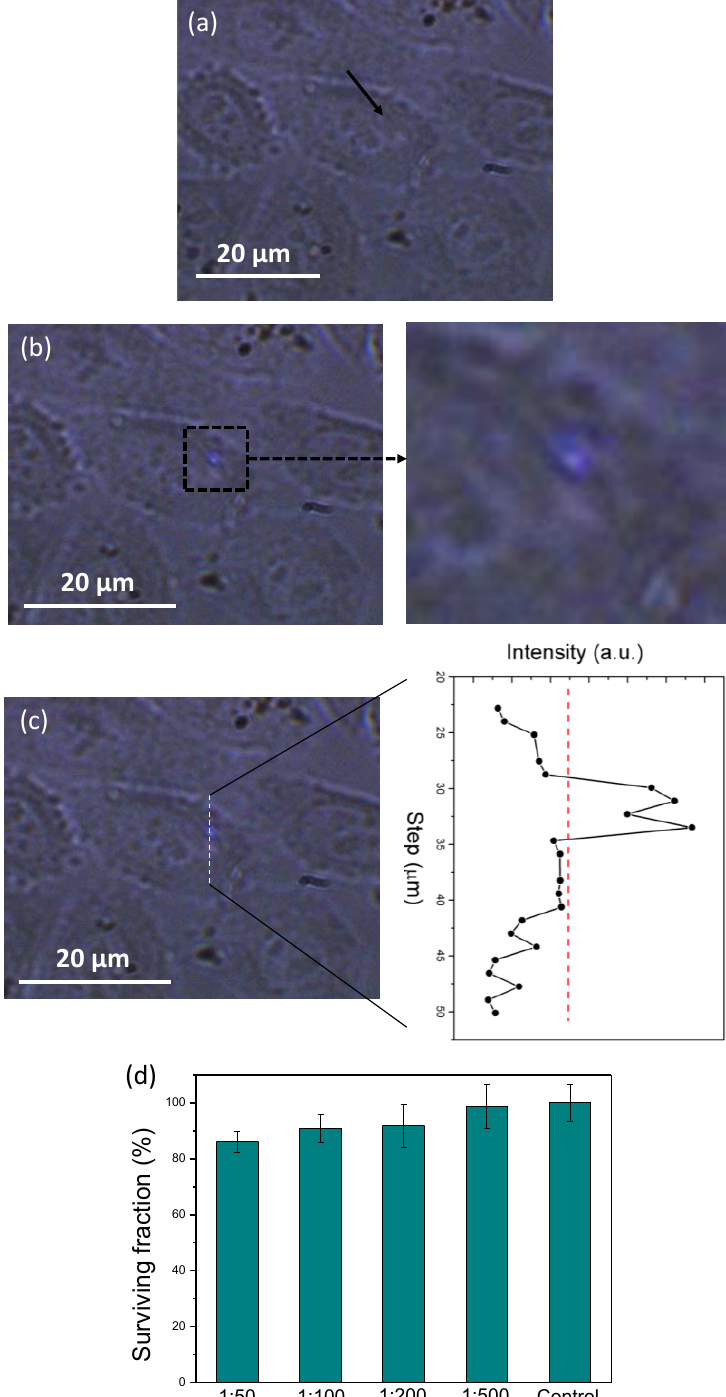
Figure 5. Microscope optical transmission images of the HeLa cells incubated with Tm,Yb:GdVO 4 @SiO 2 core-shell nanoparticles when the excitation laser is ( a ) off, and ( b ) on. The arrow indicates the position were the core-shell nanoparticles are located, as can be seen when the laser is on in ( b ), together with an enlarged image of the square area indicated in the image. ( c ) Intensity scan of the blue emission along the dashed line indicated in the figure with a scan step of 2 μm. ( d ) Percent survival of HeLa cell line incubated with different concentrations of Tm 3+ ,Yb 3+ :GdVO 4 @SiO 2 core-shell nanoparticles. Each point corresponds to the mean value ± standard deviation from five different experiments.